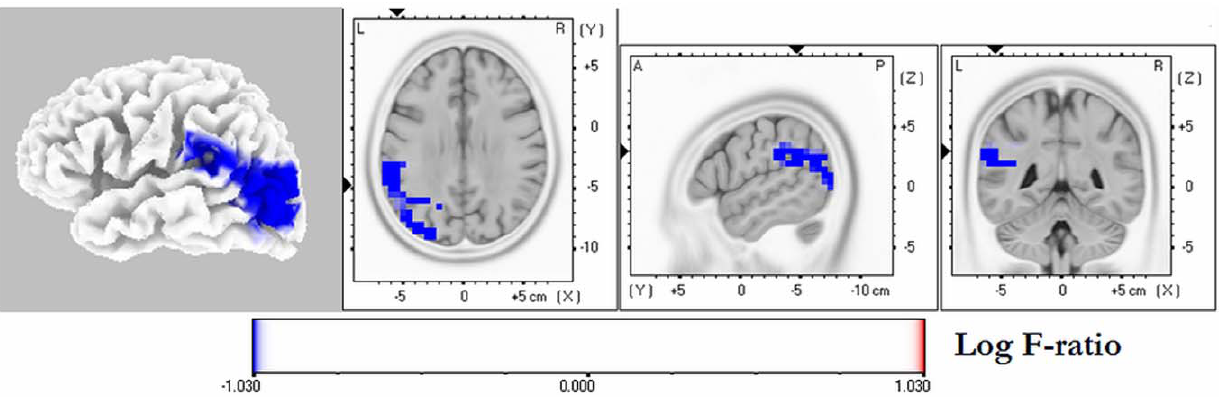
Figure 3. eLORETA statistical maps of alpha1 oscillations in patients with Alzheimer’s disease carrying the APOE -4 allele vs. noncarriers. Colored areas represent the spatial extent of voxels with significant difference in source current density (p , 0.05, corrected). The MRI slices are located at the MNI-space coordinates of the voxel with highest significance. The color scale represents log F-ratio values (threshold: log- F= 2 1.03, p , 0.05). L, left; R, right; A, anterior; P, posterior.